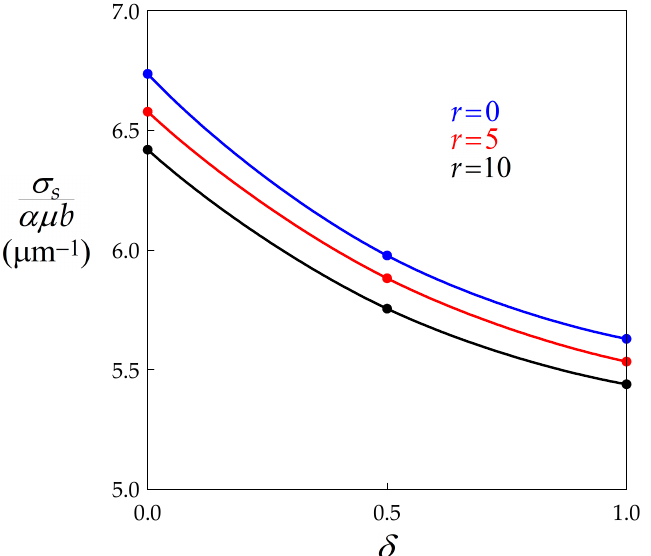
Figure 3. Diagram showing the dependence of the reduced steady state flow stress on the BMIS parameter for three values of the recovery coefficient r . Data points are connected by spline curves.